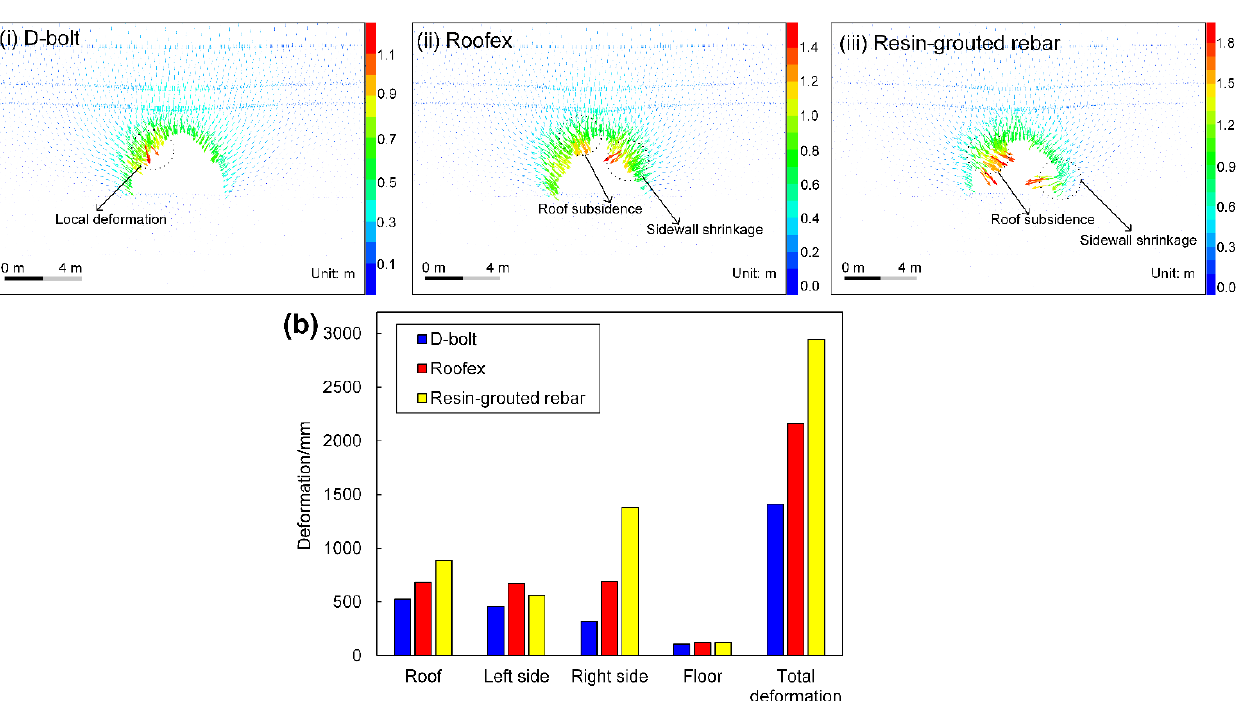
Figure 13. Simulated velocity distribution of the surrounding rock masses along the tunnel sup- ported by different types of rockbolts. ( a ) D-bolt; ( b ) Roofex; ( c ) Resin-grouted rebar.